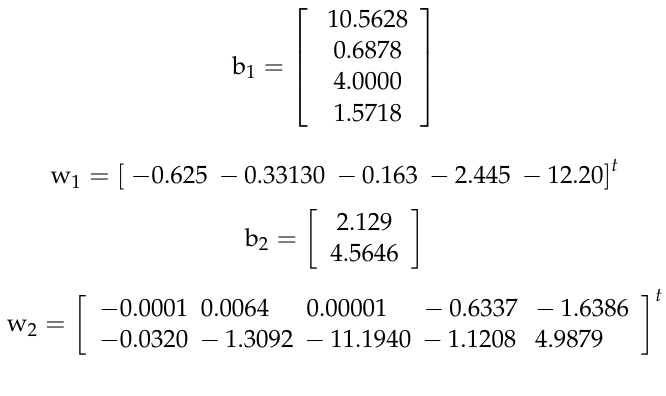
Figure A7. Neural network training